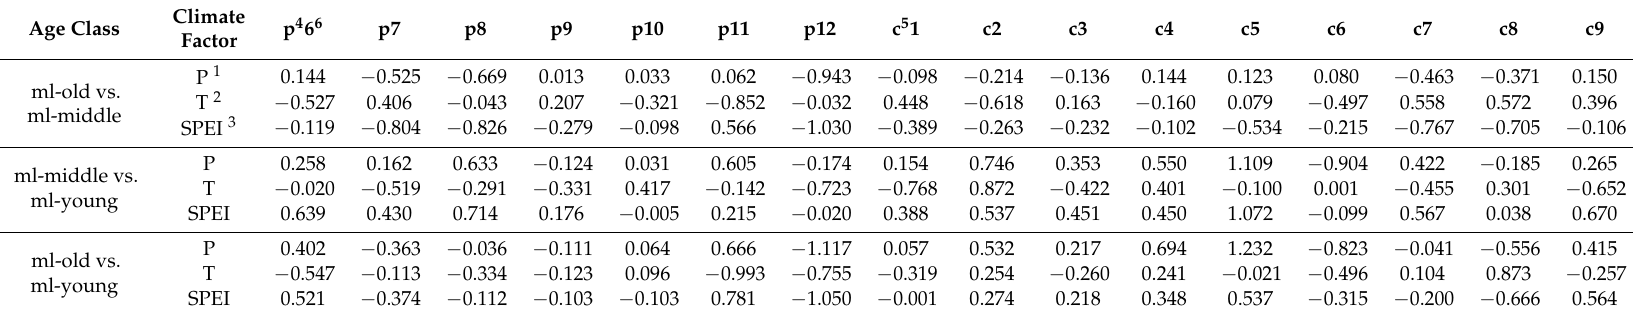
Table 3. Discrepancies in correlation coefficients between tree-ring width chronologies from three age-classes of Schrenk spruce trees and monthly climate factors by calculating the value of u (the quantile of standard normal distribution by u test method) during 1960–2012 in the eastern Tianshan Mountains.